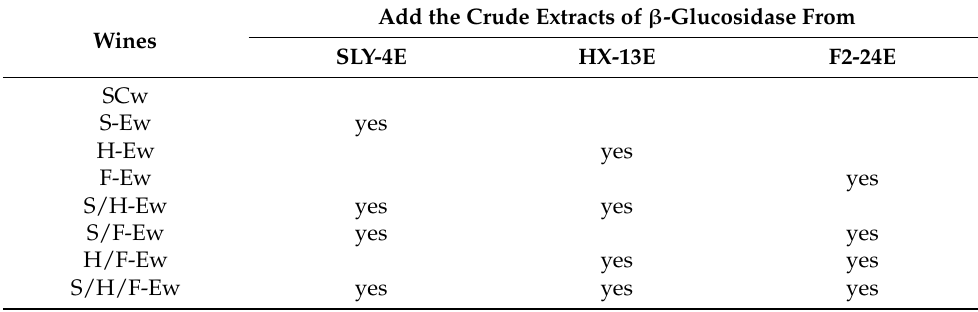
Table 1. Adding strategies of crude extracts of β -glucosidase in